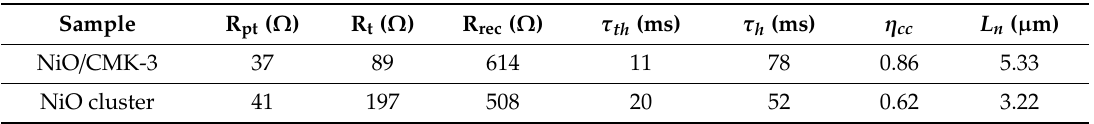
Figure 6. Nyquist plots of the p -DSSCs made of two nanomaterials and the insert is the equivalent circuit for the impedance spectrum. R s : serial resistance; R t : transport resistance of the film; R rec : the recombination resistance of the film; R pt : charge-transfer resistance of Pt electrode; C µ : distributed capacitance of p -semiconductor; C pt : the double-layer capacitance of the platinized counter electrode. Table 2. Fitted and calculated data from EIS, IMPS, and IMVS spectra of p -DSSCs based on NiO / CMK-3 and NiO-cluster